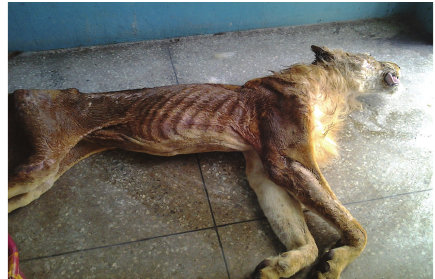
Figure 1: The result of the Hain test for the gorilla and the lioness.